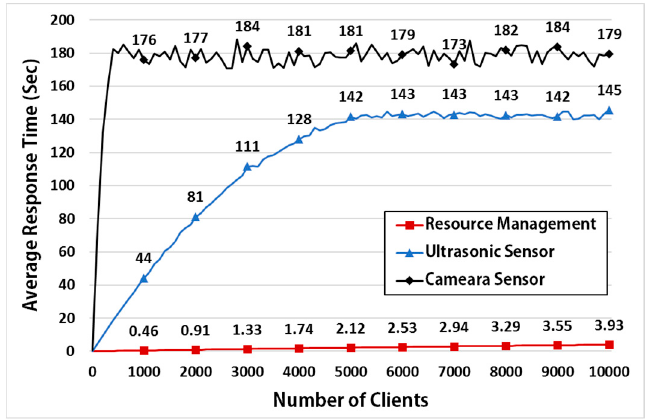
Figure 15. Response time of IoT device using ultrasonic and camera sensor.